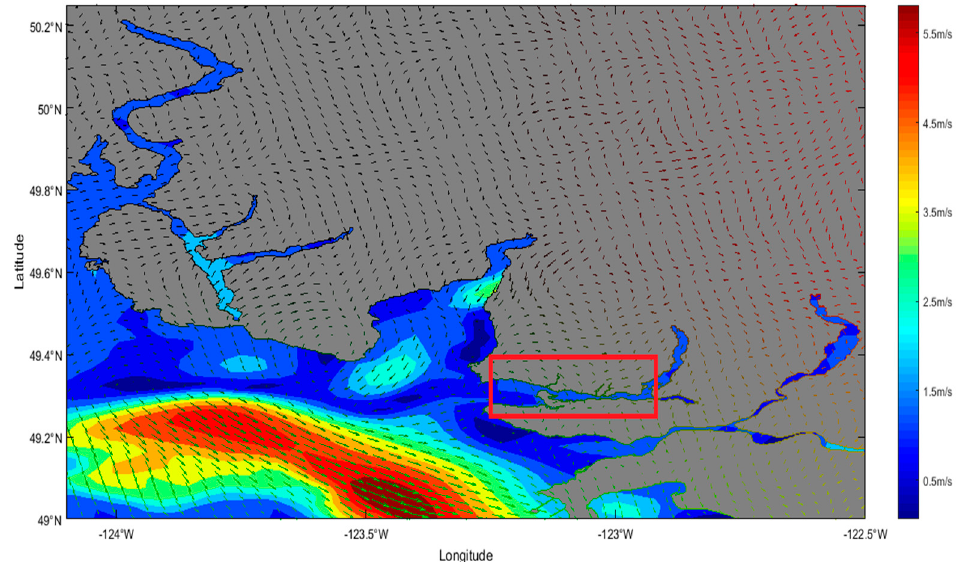
Figure 5. Wind speed and direction from the High-Resolution Deterministic Prediction System (HRDPS) (12 April 2015, 16:00). The area in the red square is the studied area.